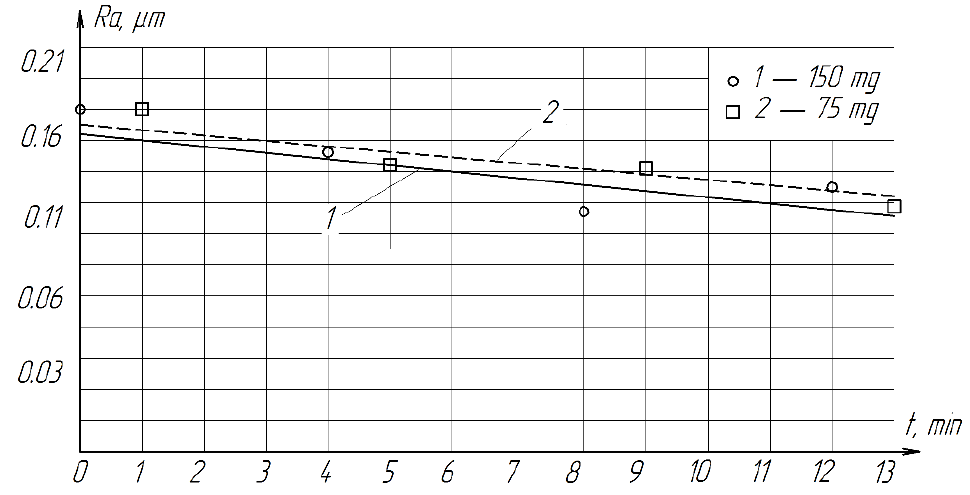
Figure 11. The effect of the amount of diamond paste on the roughness of the treated surface of ZrO 2 ceramics.